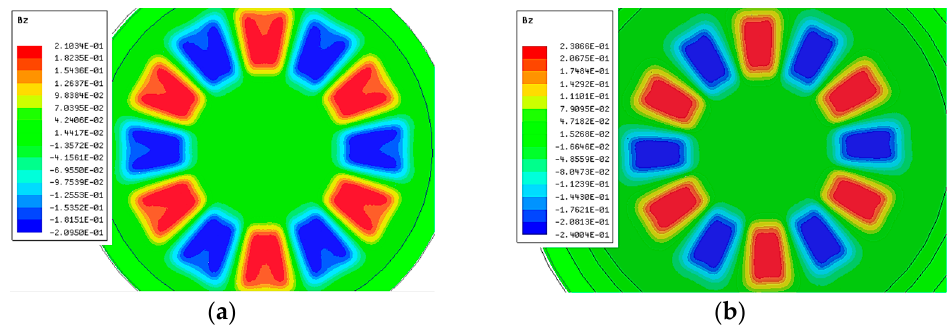
Figure 11. 3-D FEM validation of magnetic field optimization: ( a ) Conventional Halbach array; ( b ) Optimization result.